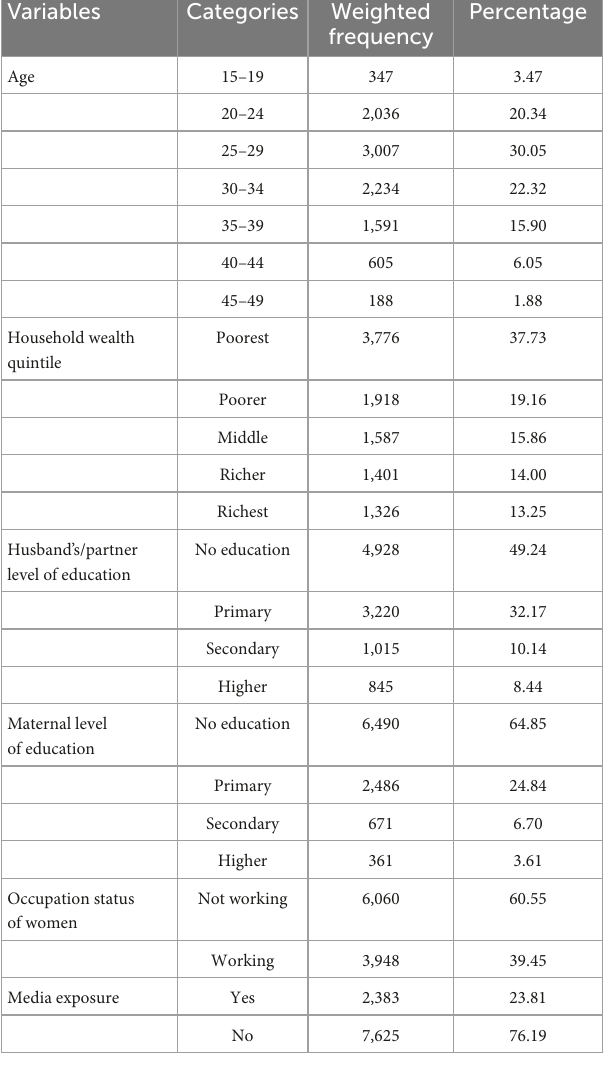
TABLE 1 Socio-demographic characteristics of the study participants.